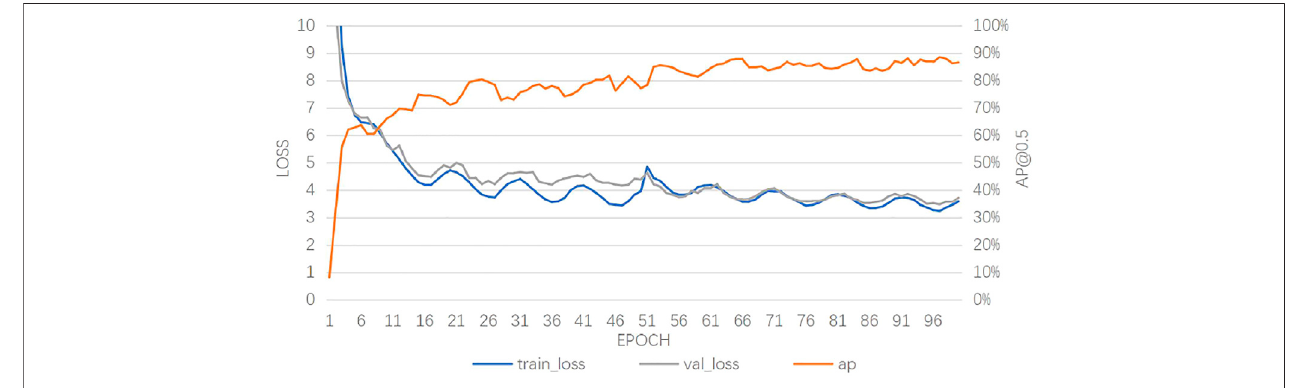
FIGURE 7 | Loss curve and AP curve during the training.